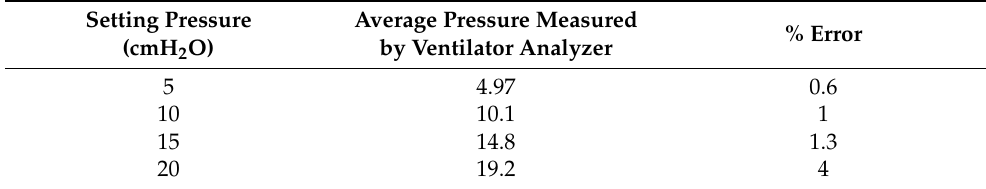
Table 5. Pressure-accuracy test.